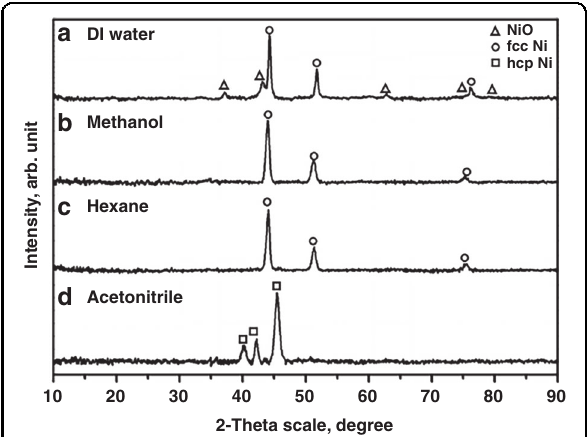
Fig. 6 XRD patterns of NPs prepared using the secondary irradiation of the obtained different phases of Ni NPs via the primary ablation of the Ni plate using various solvents. a DI water, b methanol, c hexane, and d acetonitrile 32 . Copyright